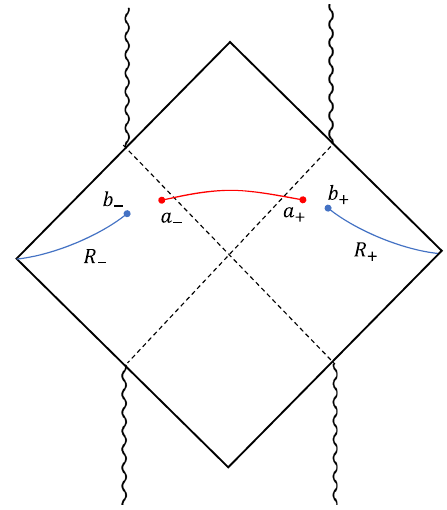
Fig. 3 Penrose diagram of an eternal Reissner–Nordström black hole [12] in the presence of island